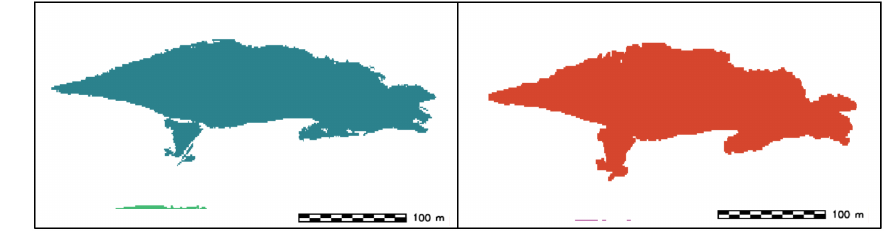
Figure 17. SW filling.